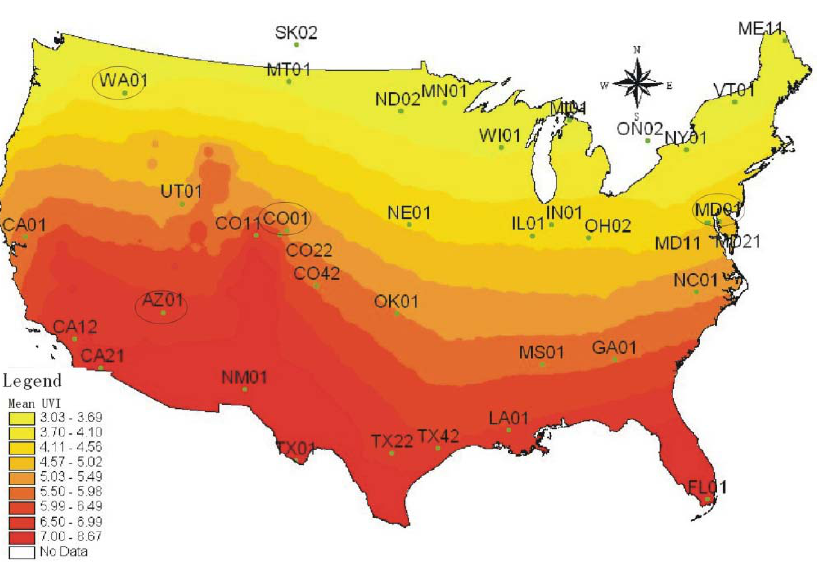
Figure 1. Map of the 37 USDA ground stations. Statistical analyses focused on the four circled